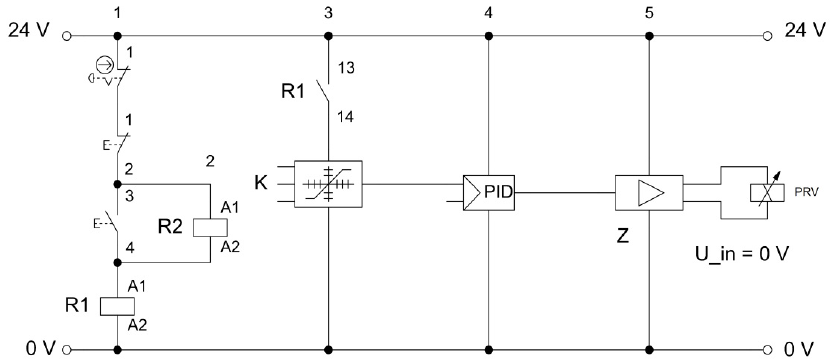
Figure 6. Electric circuit for controlling the electro-hydraulic proportional valve.